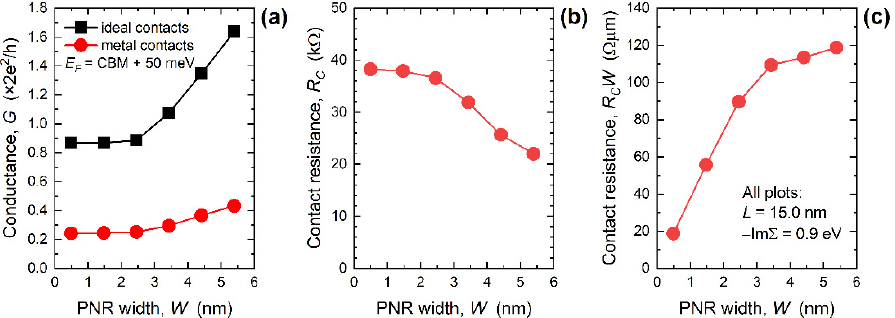
Figure 3. Width-dependence of ( a ) conductance, ( b ) contact resistance, and ( c ) width-normalized contact resistance in 15 nm-long PNRs. For all MEC-PNRs, − Im Σ R = 0.9 eV.